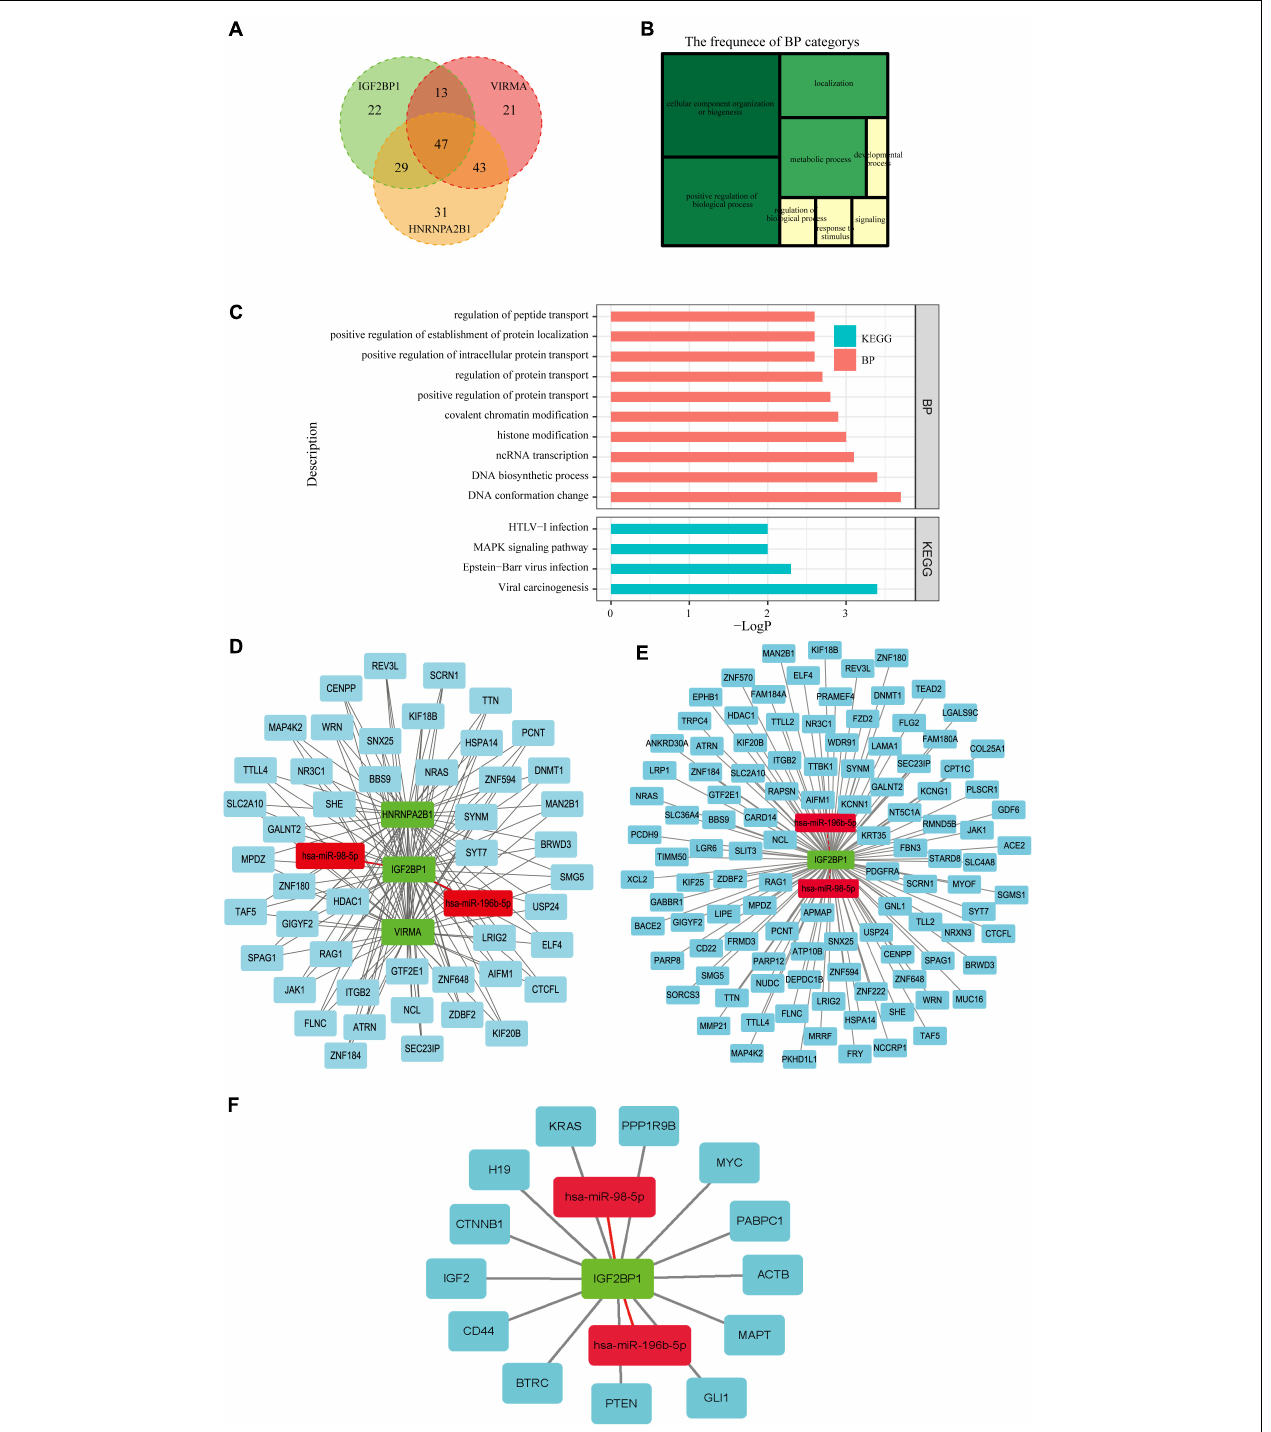
FIGURE 7 | Construction of a network of miRNAs-m6A regulators-m6A target genes. (A) Forty-seven m6A target genes potentially coregulated by the three m6A regulators (VIRMA, IGF2BP1, and HNRNPA2B1) were obtained from m6Avar, an updated database of functional variants involved in RNA modifications. (B,C) The GO analysis showed that the biological processes of the 47 genes were mainly enriched in cellular components organization and biogenesis, and positively regulated biological processes such as protein transport and localization. The KEGG pathway analysis indicated that these genes were mainly enriched in viral carcinogenesis and the MAPK signaling pathway. (D) A regulatory network of miRNAs-m6A regulators-m6A target genes was constructed, which was composed of two miRNAs, three m6A regulators, and forty-seven mRNAs. (E) A regulatory network composed of two miRNAs, IGF2BP1, and110 m6A target genes was constructed. (F) A regulatory network of two miRNAs, IGF2BP1, and 10 target genes that has been reported previously.